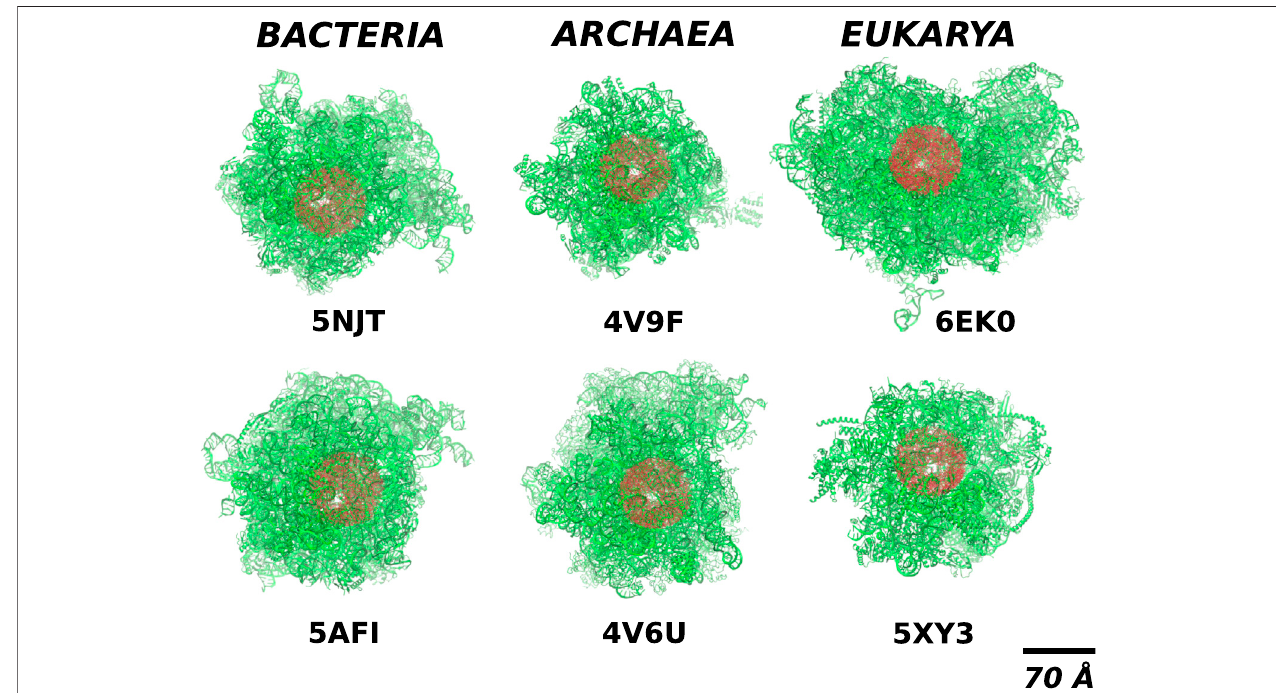
FIGURE2| Thelocationofthecylindricalcut-out(theredshadow)ofradius R R (cid:1) 70Åwithinthefullstructureofribosomes(thegreencolour)fromdifferentdomains of life. The white spot within the red blob shows the position of the exit tunnel.